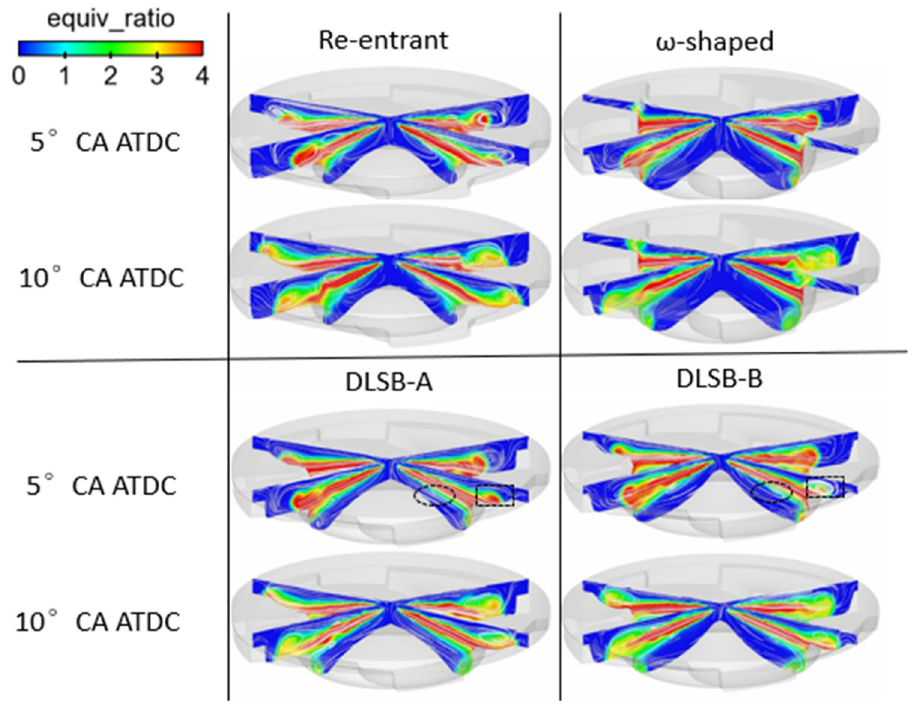
Figure 11: The distribution of equivalence ratios and streams at 5° CA ATDC and 10° CA